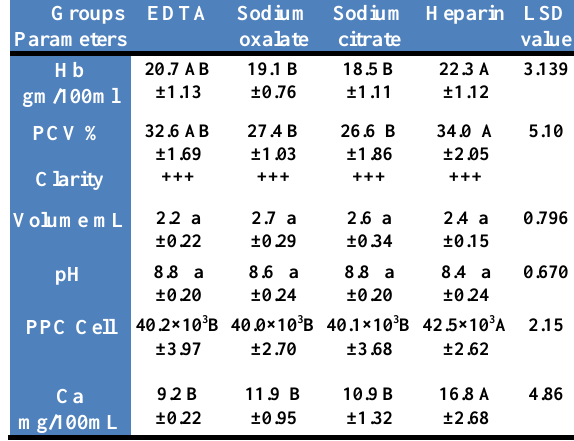
2: The effect of different types of anticoagulants on Haemoglobin, packed cell volume and plasma clarity, volume, pH, platelets count and calcium concentration of cow blood samples. Groups